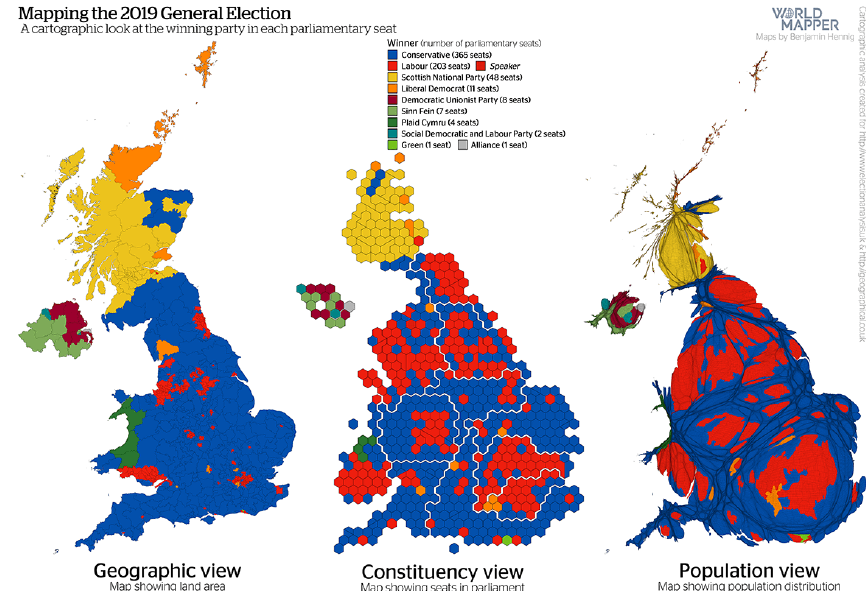
Figure 9. Benjamin Hennig’s cartograms of the United Kingdom’s 2019 General Election (available at http://www.viewsoftheworld.net/?p=5755). A gridded and a non gridded continuous cartogram are presented, along with a planimetric map, allowing for a comparison of cartogram techniques over the same data. The author bases hexagonal grid cells on electoral constituencies in the UK, but also presents a continuous cartogram distorted by population